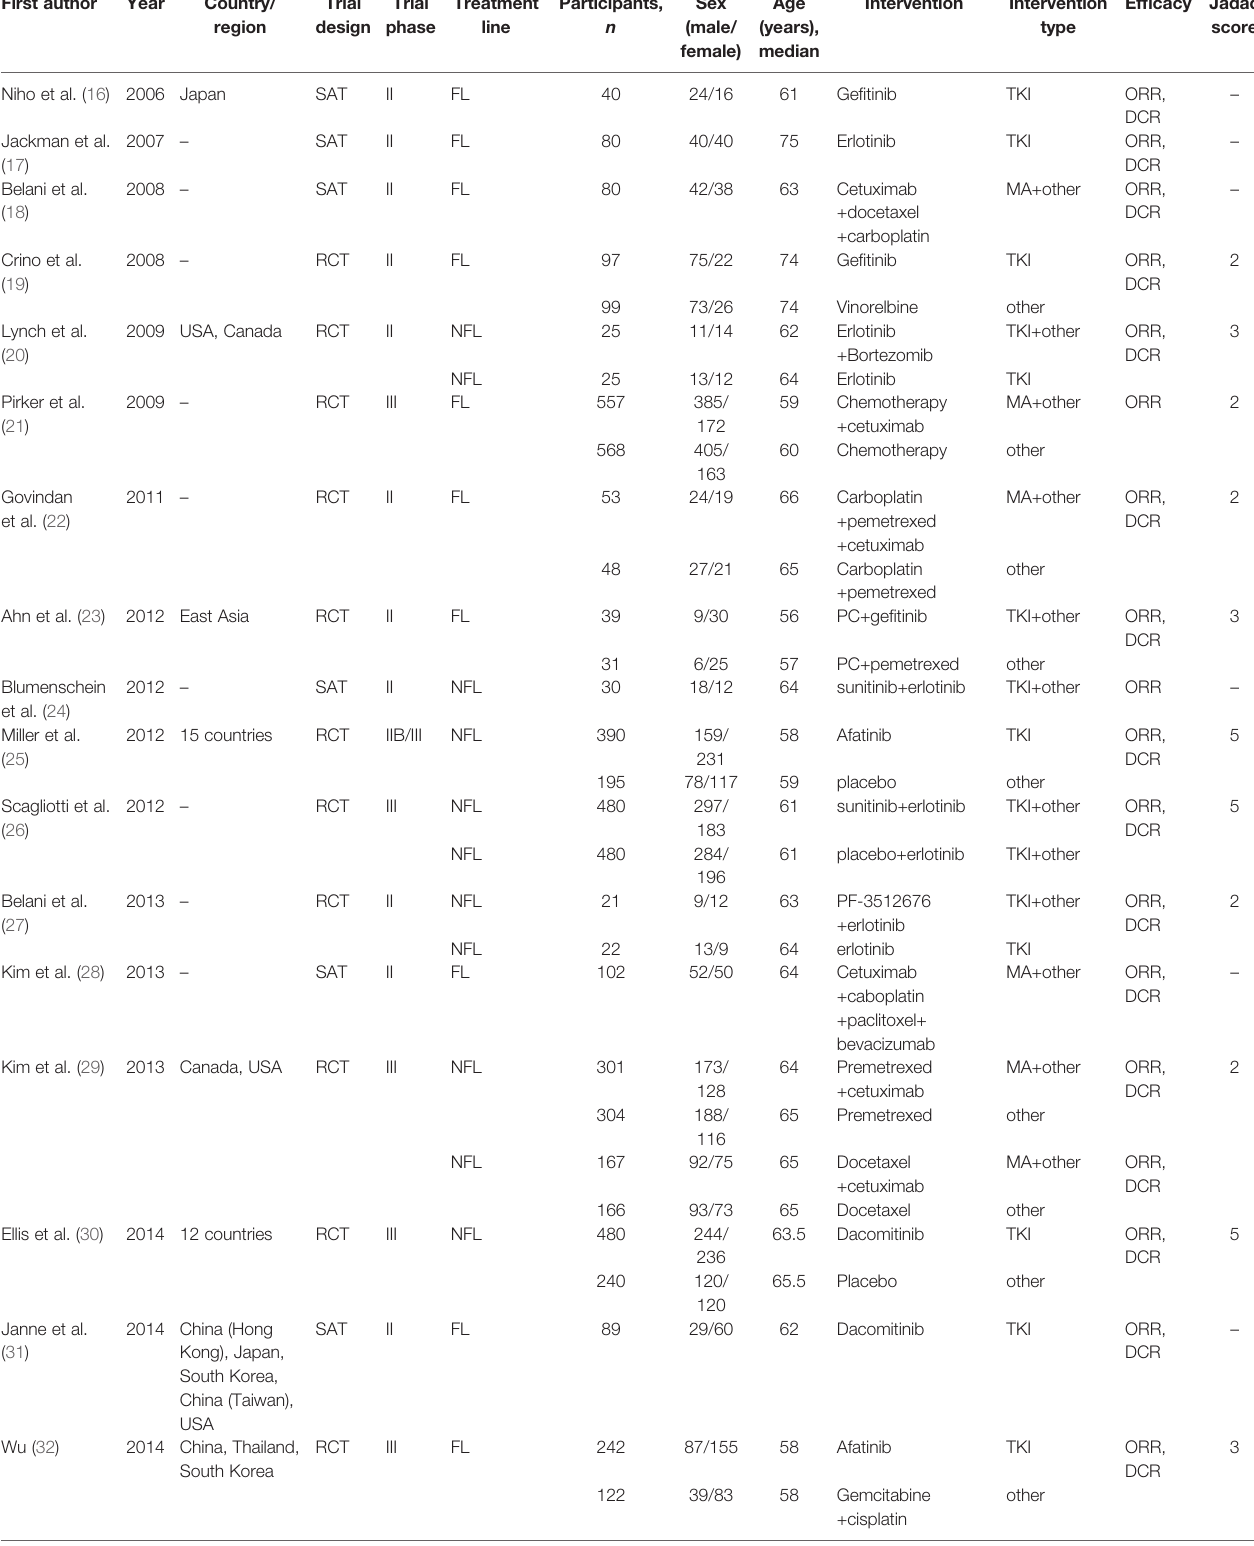
TABLE 1 | Characteristics of the studies included in the